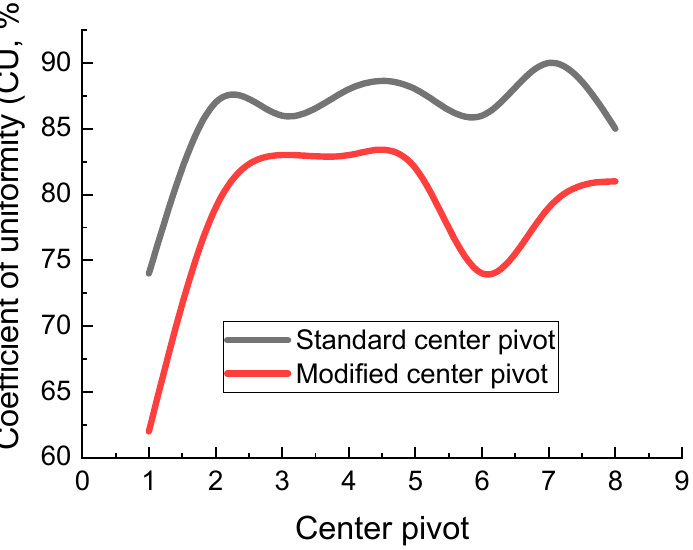
Figure 8. A comparison between the coefficient of uniformity (CU) for both the standard- and modified-laterals of the tested center pivot irrigation systems.